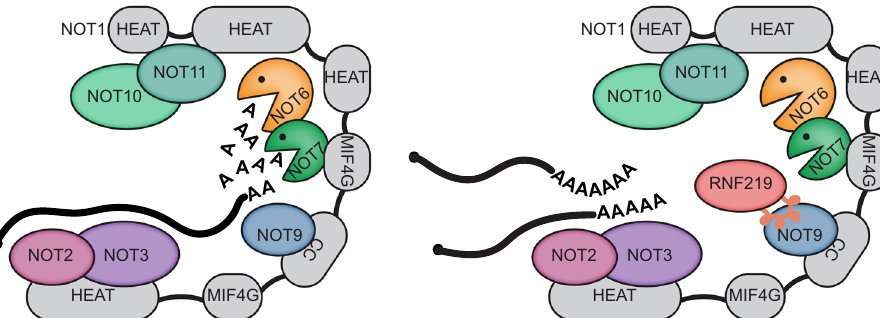
Fig. 8 Model of CCR4-NOT-mediated deadenylation and its inhibition by RNF219. The non-catalytic NOT2/3 and NOT9 modules facilitate access of substrate poly(A) RNA to the catalytic NOT6/NOT7 module and thereby promote sequence-independent mRNA deadenylation. RNF219 interacts with the NOT9 module via a SLiM (depicted as a helical peptide) within its C-terminal low-complexity region. RNF219 may occupy the RNA interaction surface on NOT9 and hinder access of poly(A) RNA to the catalytic module. Alternatively, RNF219 may reduce the catalytic activity of CCR4 or CAF1, given the proximity of the NOT9 and the catalytic module. Inhibition of CCR4-NOT-mediated deadenylation by RNF219 occurs in the absence of its N-terminal RING domain and thus, is independent of its E3 ligase activity. The N-terminal RING domain of RNF219 is dispensable for stabilization of short-lived mRNAs yet required for stabilization of long-lived